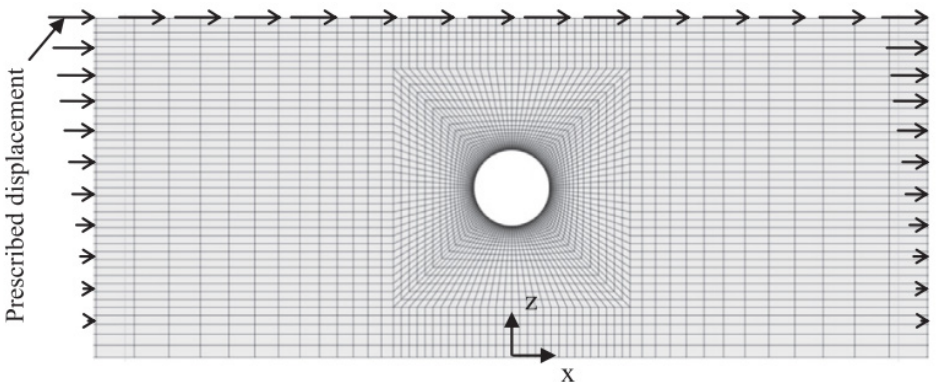
Figure 3. Geometry and quasi-static loading conditions for the circular tunnel model [25].